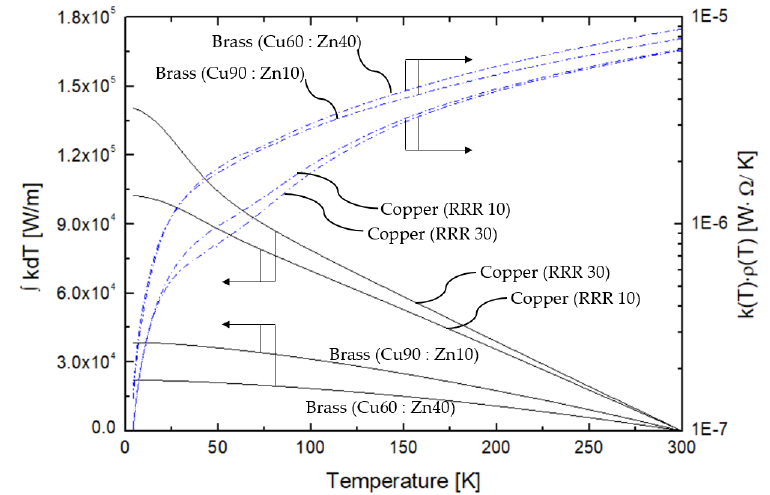
Figure 3. Thermal properties of metals as a function of temperature.